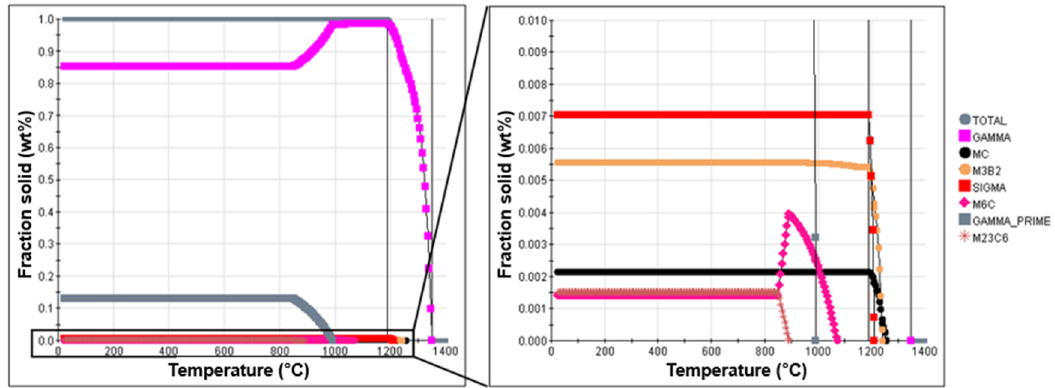
Figure 15. JMatPro simulation predicting precipitates forming in Haynes ® 282 ® .